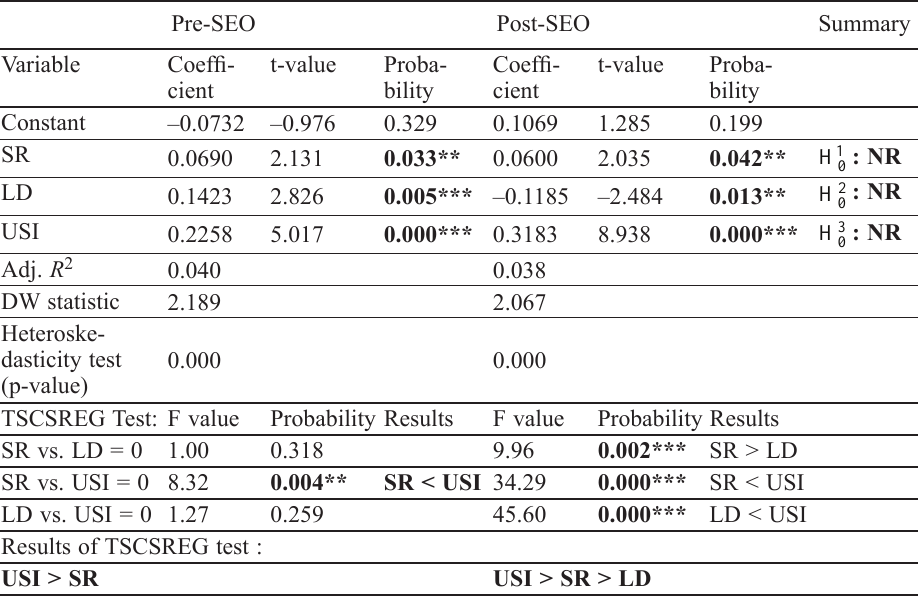
Table 11. Robustness checking: Two-way random effects model of Asian markets – excluding insigni fi cant variables in initial